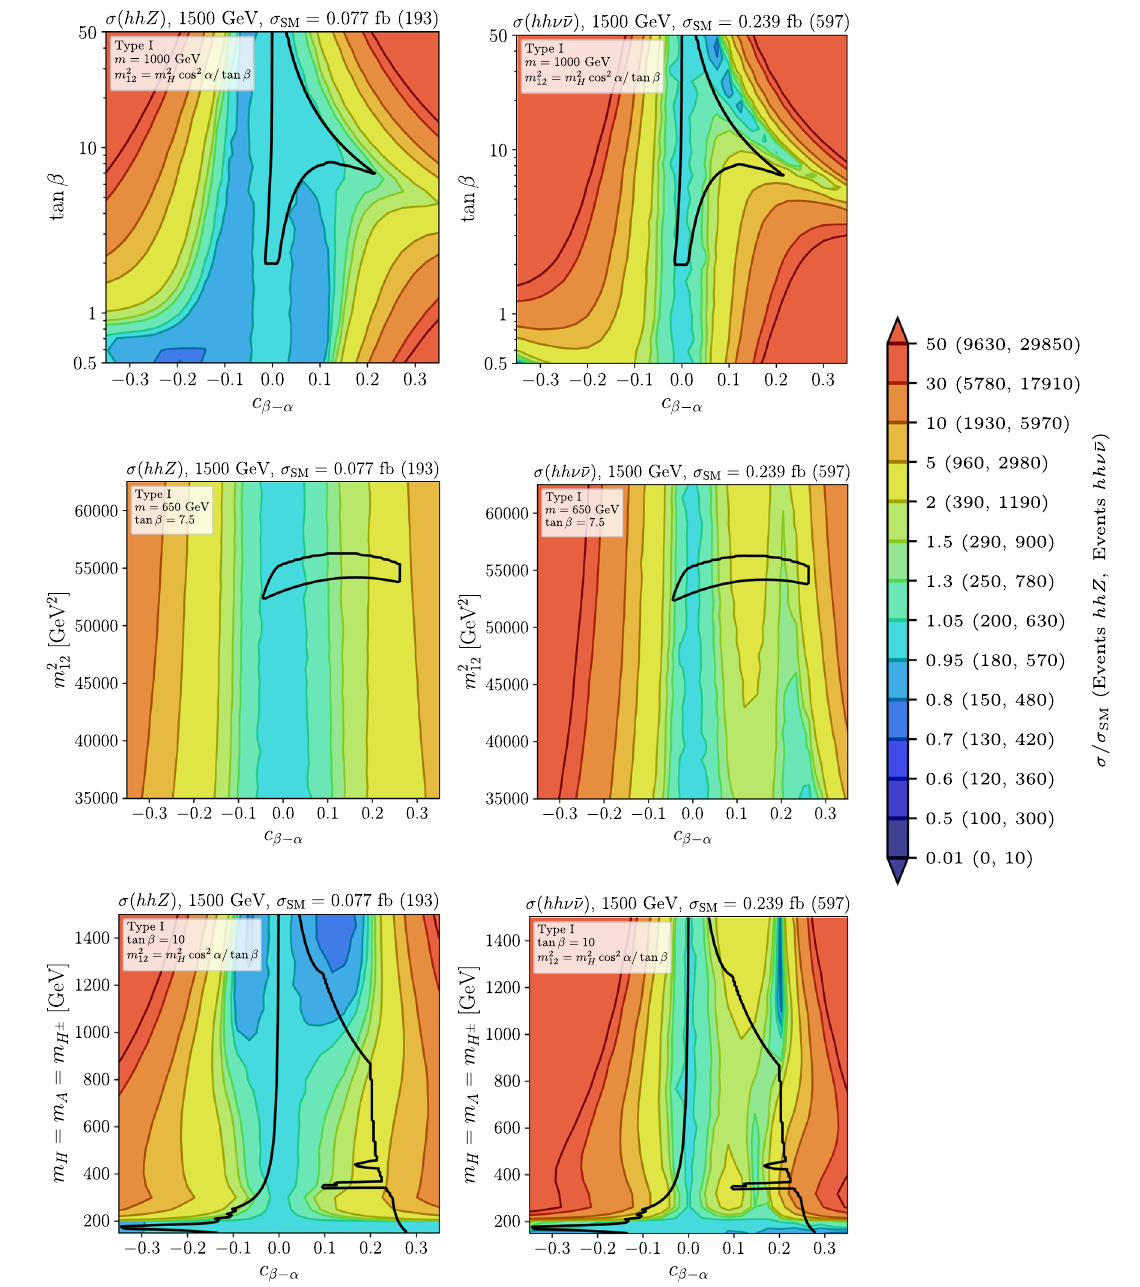
√ s = 1500 GeV for the benchmark planes 1-3 (top to bottom). The